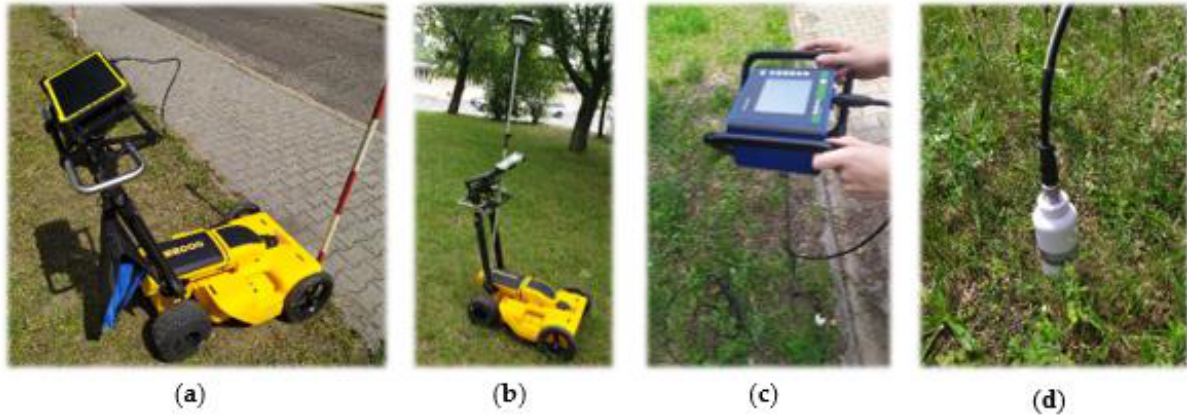
Figure 1. View of the Leica DS2000 GPR used during the infrastructure detection test: ( a ) general view; ( b ) GNSS receiver integrated with GPR; ( c ) Eijkelkamp Penetrologger sensor; ( d ) view of the soil sensor.